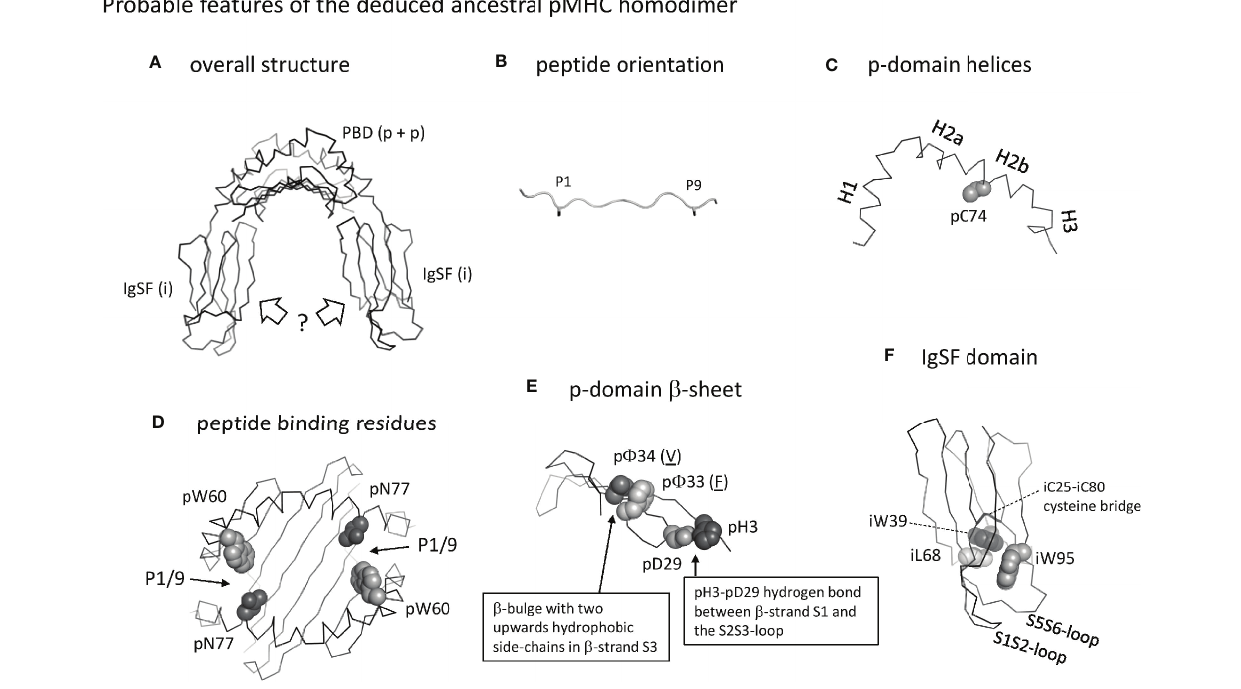
FIGURE 13 | Probable features of the deduced ancestral pMHC homodimer. (A) Overall structure shown without peptide ligand. The peptide binding domain (PDB) consisting of two identical p domains was roughly similar to as found in extant pMHC. The orientation of the IgSF domains is very speculative, and possibly was as known for ib domains in extant pMHC (as shown in the fi gure) or more as structures found in antibodies (not shown). (B) The orientation of the peptide ligand probably was as in extant pMHC-II, with overhanging peptide ends and the sidechains of the P1 and P9 residues (shown until the C b atom in black sticks format) pointing downwards into the groove. (C) The p-domain helical regions were probably as in pb domains of extant pMHC-I and pMHC-II: helices H1, H2a, H2b, and possibly H3 were separated by kinks and formed a structure curving over the b -sheet, and a cysteine at position 74 in the H2b helix participated in a disul fi de bridge with the underlying b -sheet (the b -sheet is not shown here). (D) Peptide binding residues. The groove was probably open at both sides allowing overhang of peptides as in extant pMHC-II, and important binding residues were pW60 and pN77 as in the pb domain of extant pMHC-II. Positions of the P1/9 pockets are indicated. (E) The p-domain b -sheet. As in extant pMHC, each p-domain contributed four strands of a b -sheet, with a b -bulge in b -strand S3 at positions 33 and 34 with hydrophobic sidechains pointing upward (the p33 and p34 residues shown are just examples, as indicated by their underlining). As common among pa domains in extant pMHC-I and pMHC-II, and pb domains in extant pMHC-I, there was a hydrogen bond between pH3 and pD29. (F) The homodimer IgSF domain presumably had a structure similar as in extant pMHC-II ia domain, with an IgSF typical core including the iC25-iC80 cysteine bridge and the hydrophobic interacting residues iW39 and iL68. The orientation of the S1S2 plus S5S6 loops was unusual compared to other C1 category IgSF domains and formed a structure together with a unique iW95 residue. For more information see Supplementary File 5